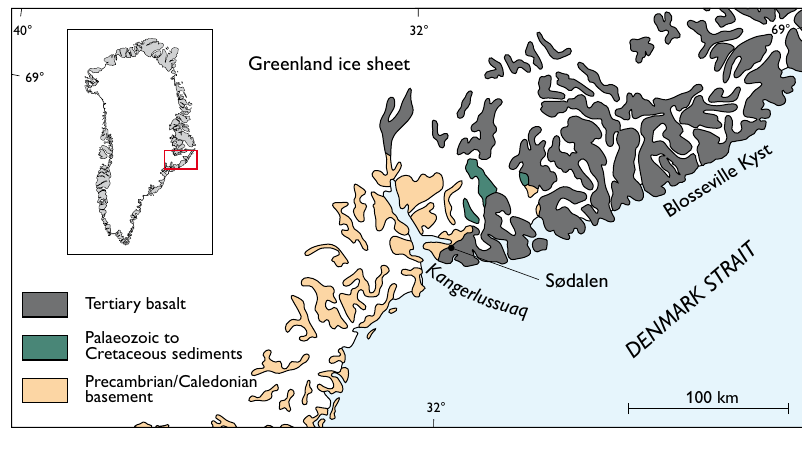
Fig. 1. Distribution of the Palaeozoic to Cretaceous sediments in the Kangerlussuaq area, southern East Greenland, and their close relation to the Tertiary plateau basalt (modified after Henriksen et al .